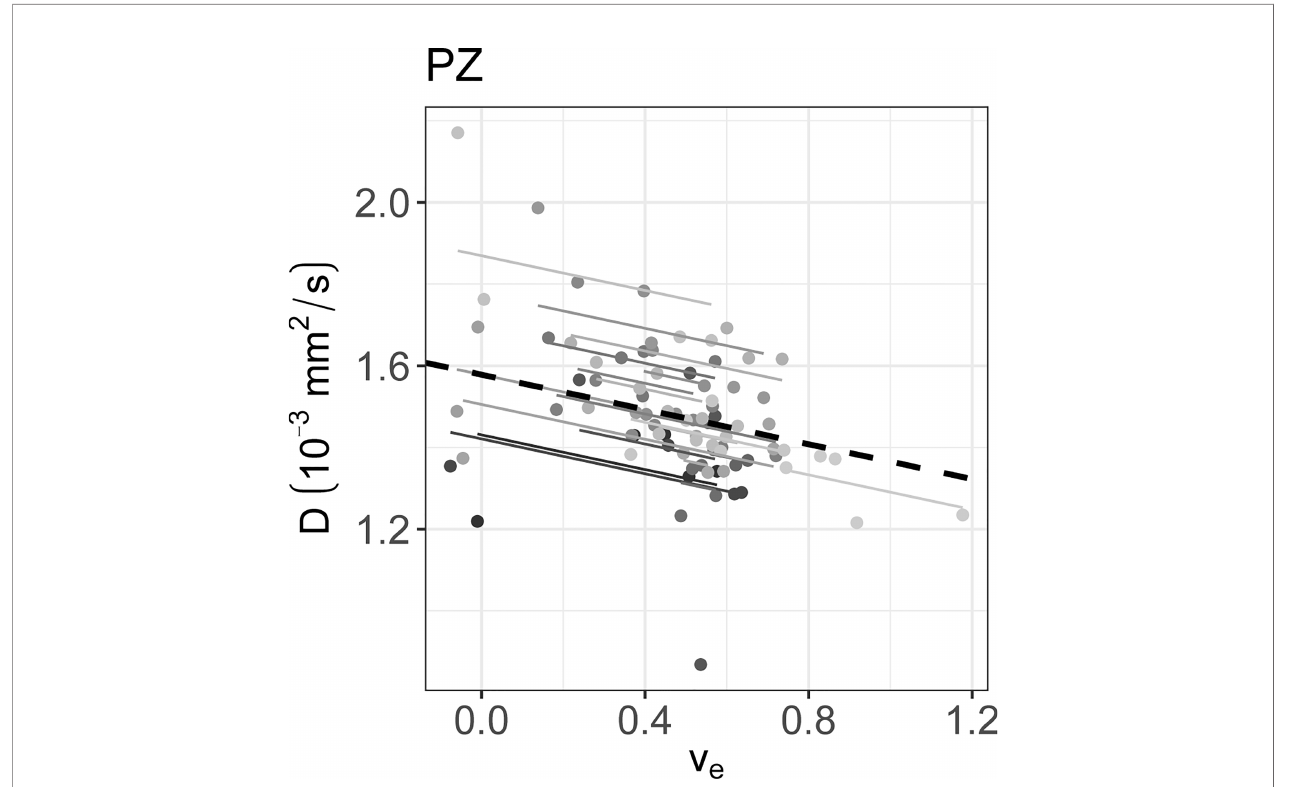
FIGURE 3 | The signi fi cant repeated measures correlation of D with the DCE parameters are shown. D only correlated signi fi cantly with v e in the PZ. Each line shows the fi t for a single patient and the dashed black line shows the overall common